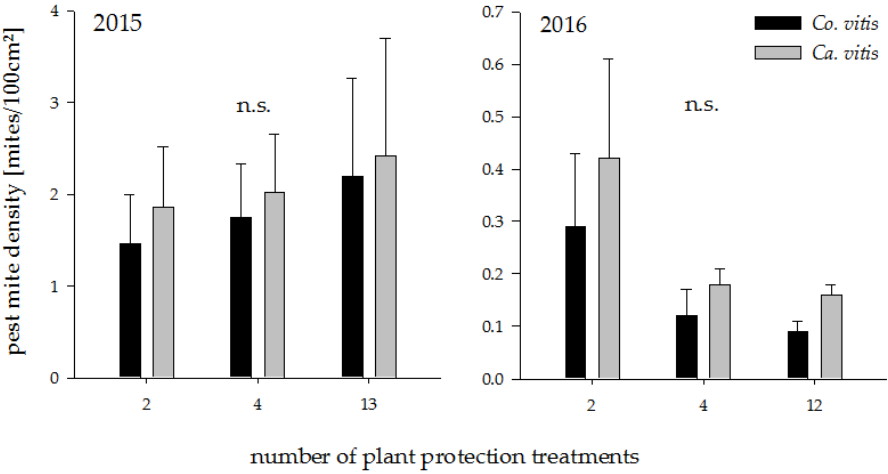
Figure 2. Pest mite density in plots with increasing plant protection intensities in the years 2015 and 2016. n.s. indicates a non-significant difference between groups ( p > 0.05). Values represent means + standard error (N = 24). Co. = Colomerus ; Ca. = Calepitrimerus